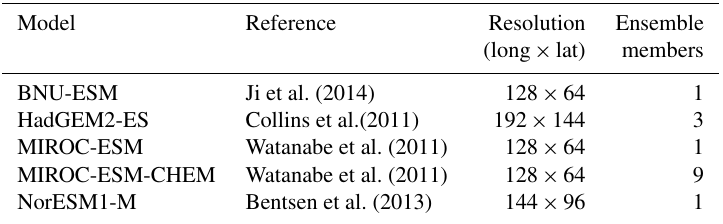
Table 1. Climate models used in this study.